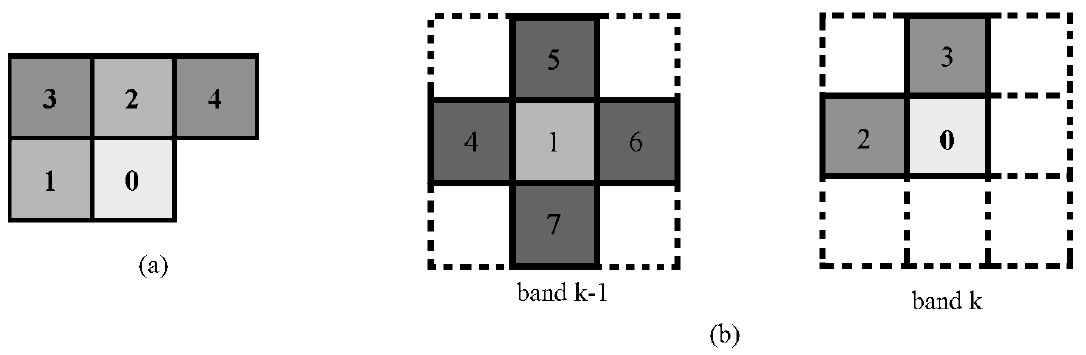
Figure 7. The resulting context for intra-band and inter-band